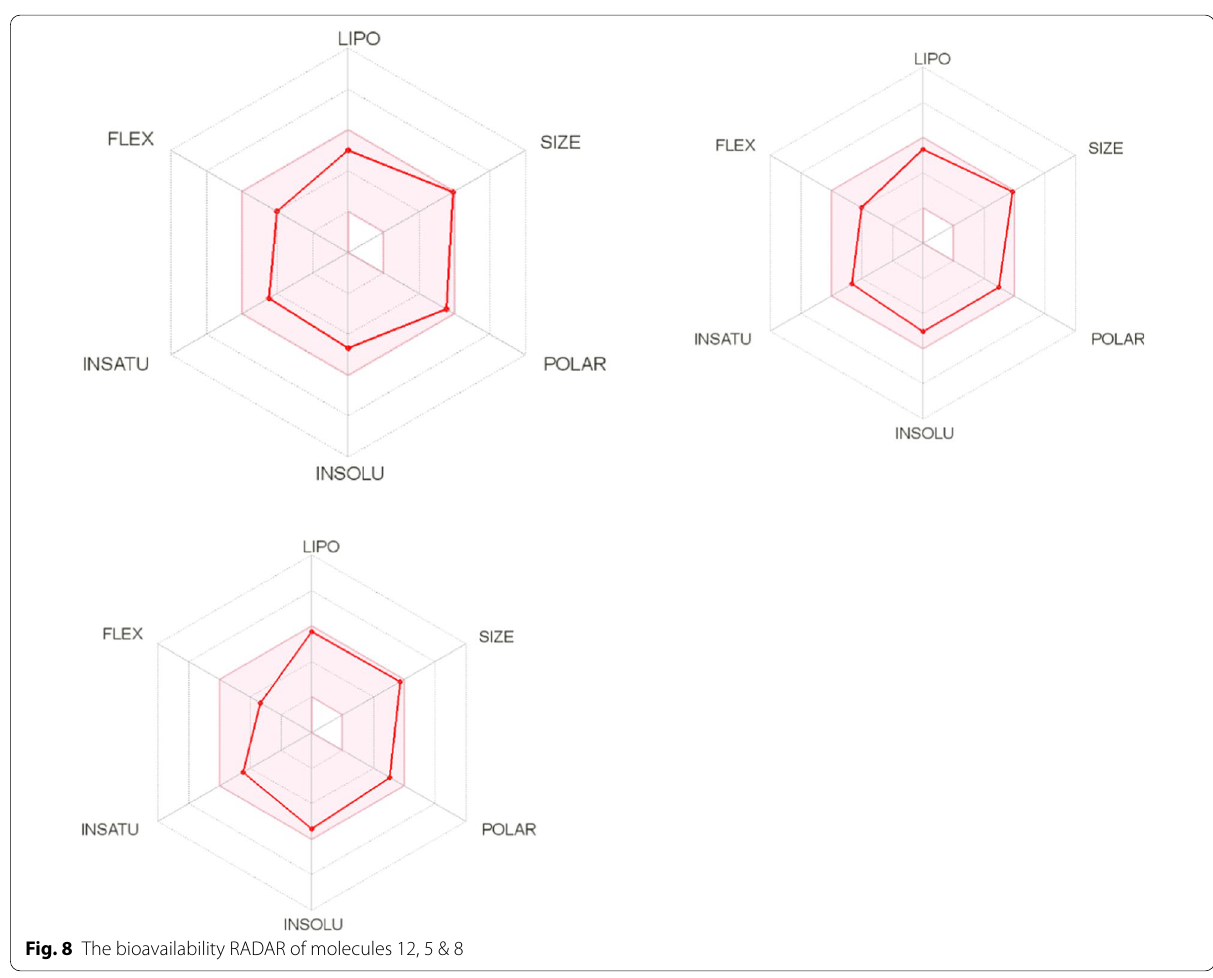
Fig. 8 The bioavailability RADAR of molecules 12, 5 & 8